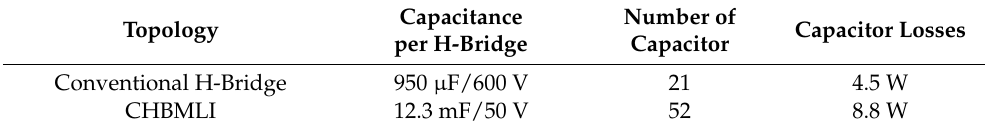
Table 8. Comparison of the capacitor design. Topology